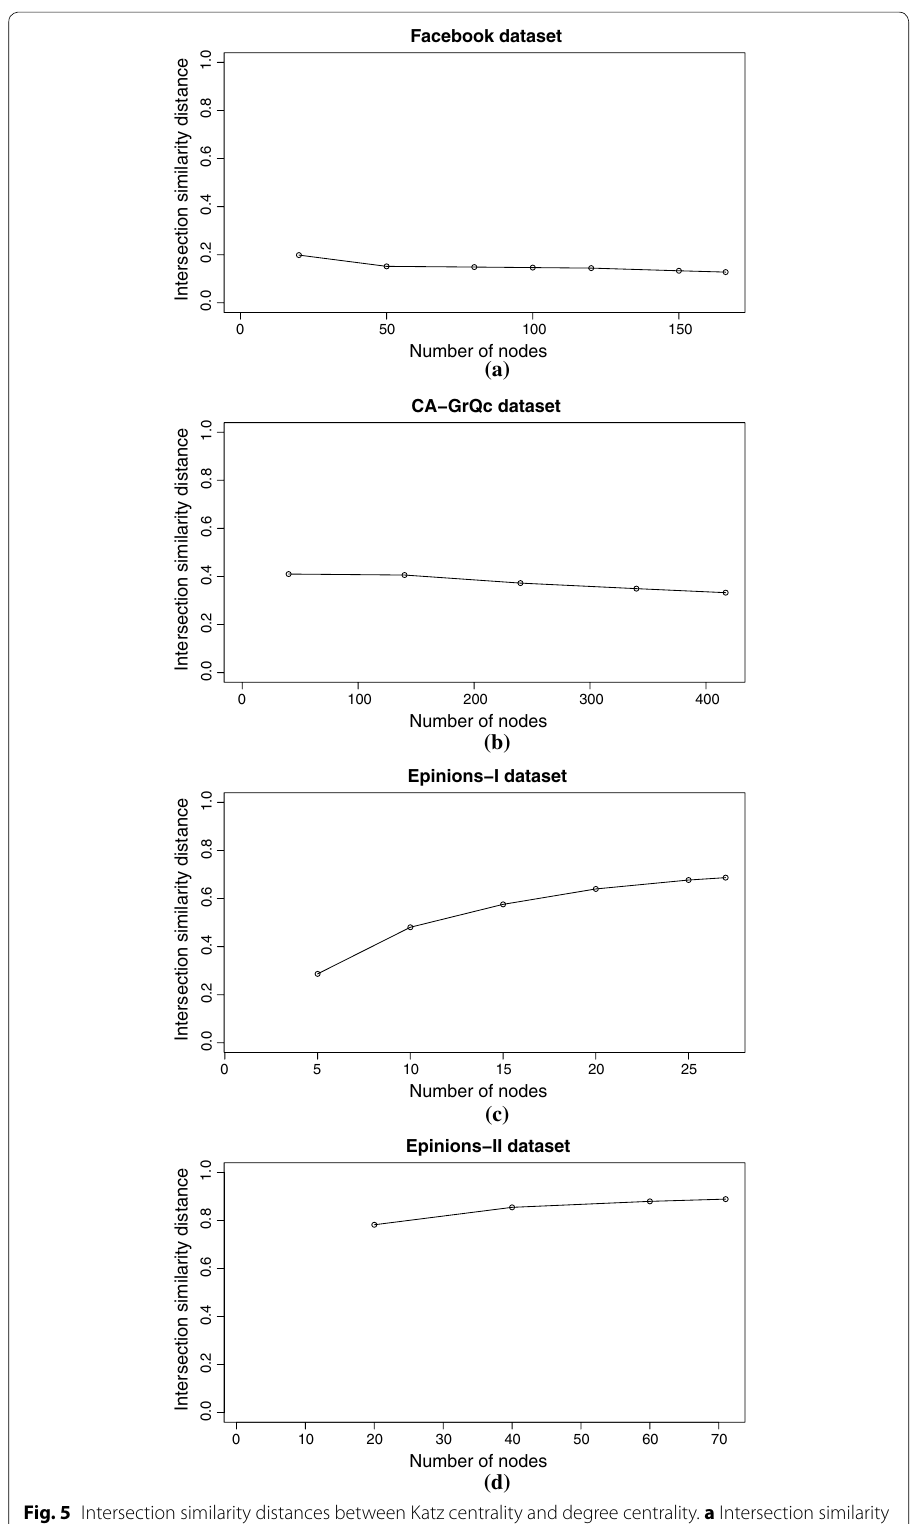
Fig. 5 Intersection similarity distances between Katz centrality and degree centrality. a Intersection similarity distances for Facebook dataset. b Intersection similarity distances for CA-GrQc dataset. c Intersection similar- ity distances for Epinions-I dataset. d Intersection similarity distances for Epinions-II